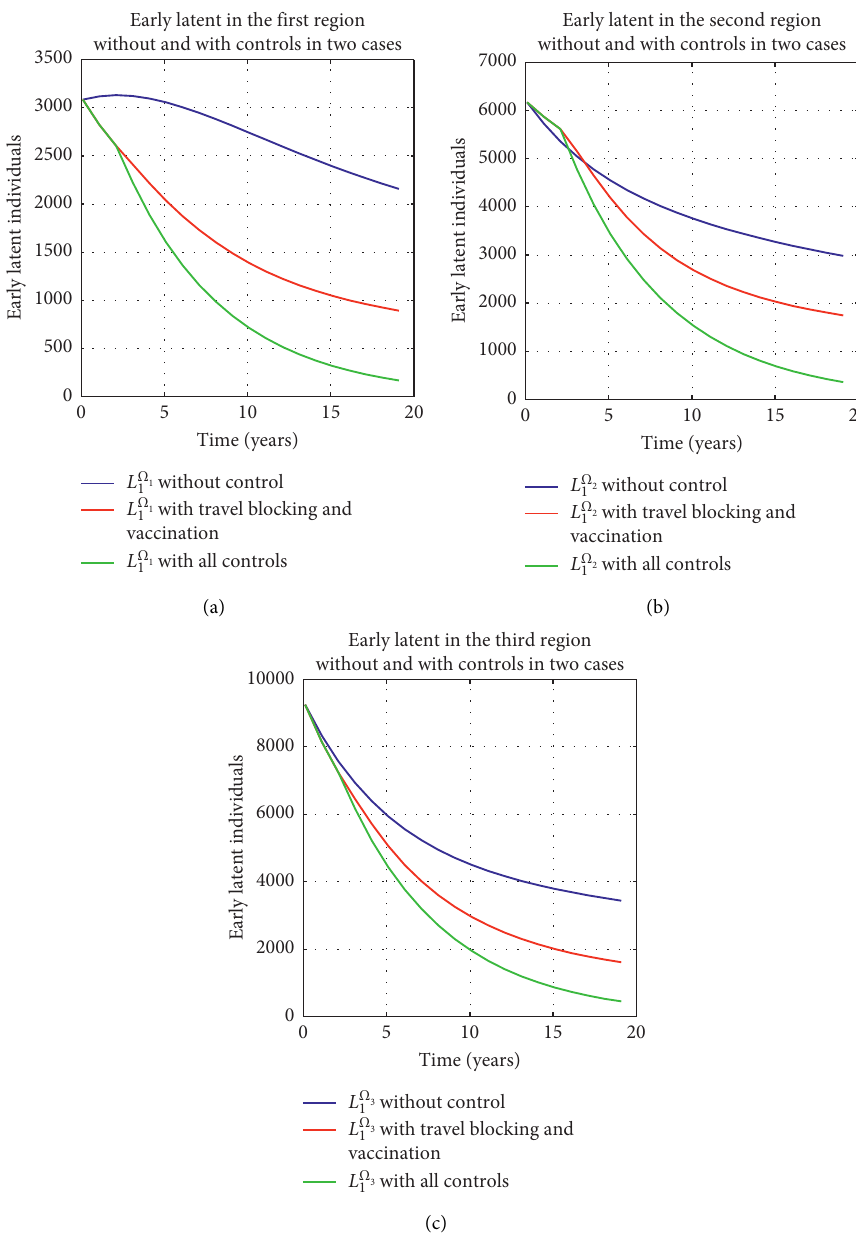
Figure 10: Comparison of the early latent in each region without control and with control in two